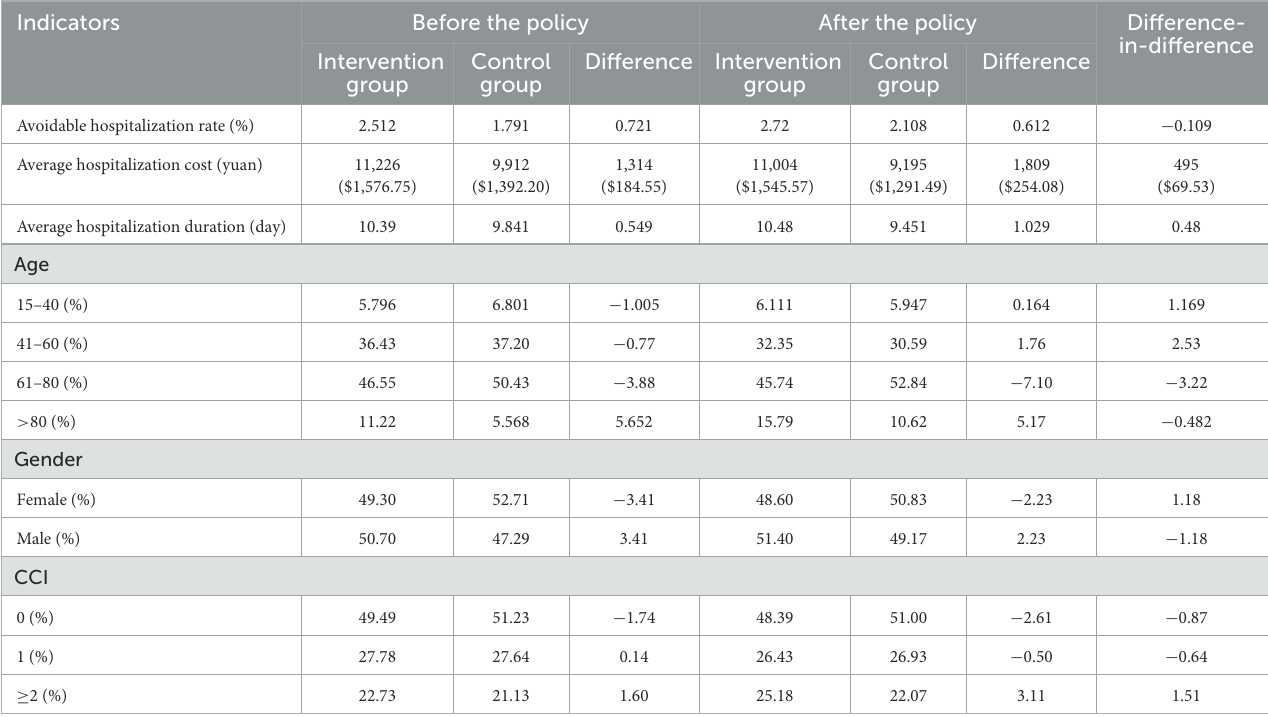
in-difference Intervention Control Difference Intervention Control Difference group group group group